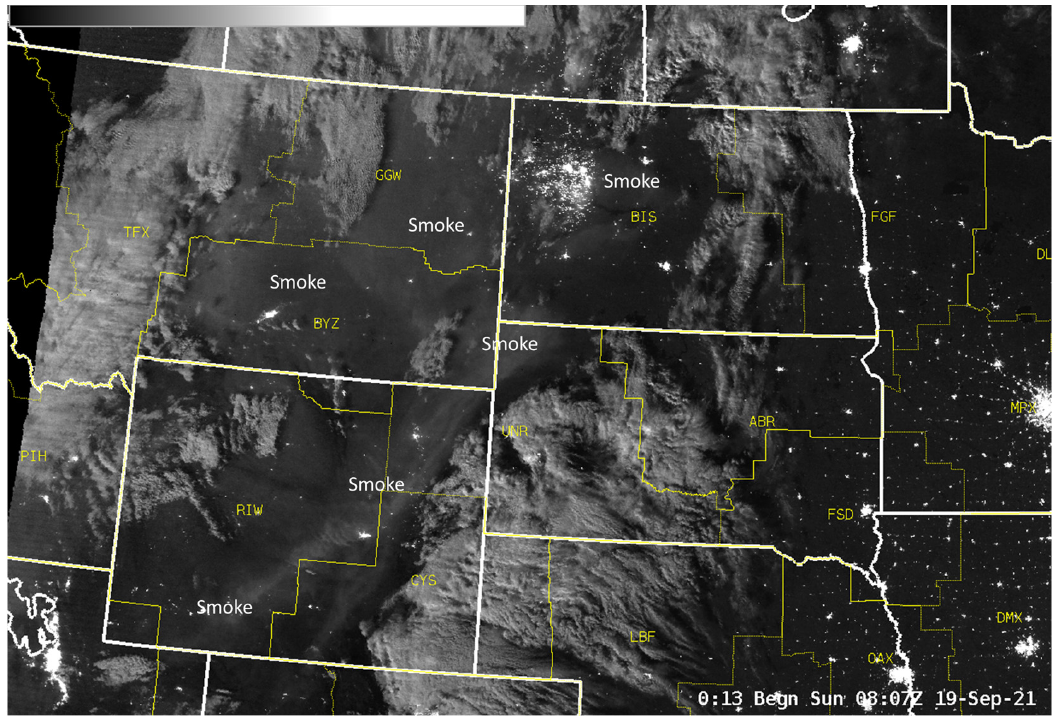
Figure 4. Smoke signal (SE of RIW) from 0807 UTC 19 September 2021 as observed from the near- constant-contrast (NCC) product from the VIIRS. White lines are state boundaries, while yellow lines and text are NWS County Warning Area boundaries and Weather Forecast Office abbreviation, respectively. Gray scale colormap represents NCC puesdo-reflectance values from low as black to high as white. Adapted from: https://satelliteliaisonblog.com/2021/09/20/viirs-ncc-use-for- nighttime-smoke-detection/, accessed on 7 February